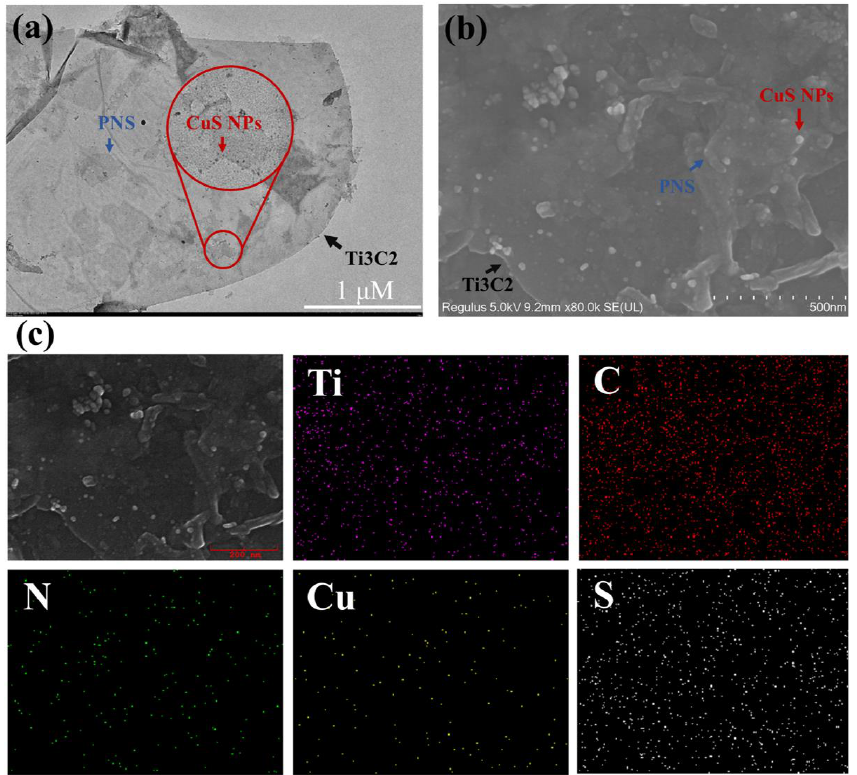
Figure 2. Characterizations of CuS-PNSs/Ti 3 C 2 nanohybrids: ( a ) TEM image; ( b ) SEM image; ( c ) SEM-based elemental mapping.